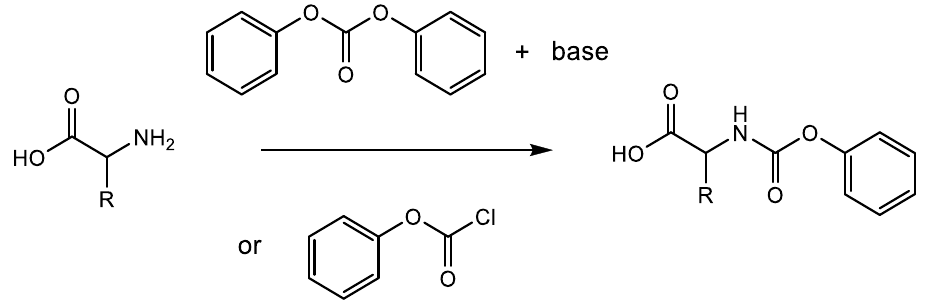
Figure 6. Synthetic methods to prepare NPC monomers.